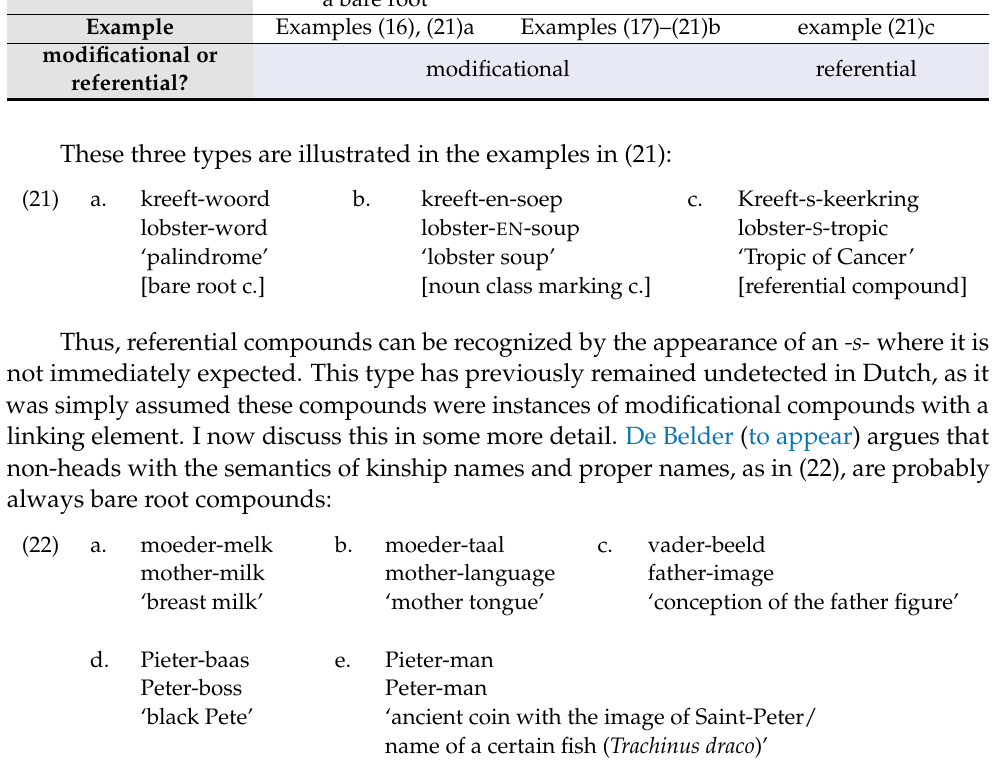
Table 1. An inventory of Dutch primary compounding. Bare Root Noun Class Marking Referential Compounding Compounding Compounding none: the non-head is “linking element”? (n)] [s] a bare root Example Examples (16),